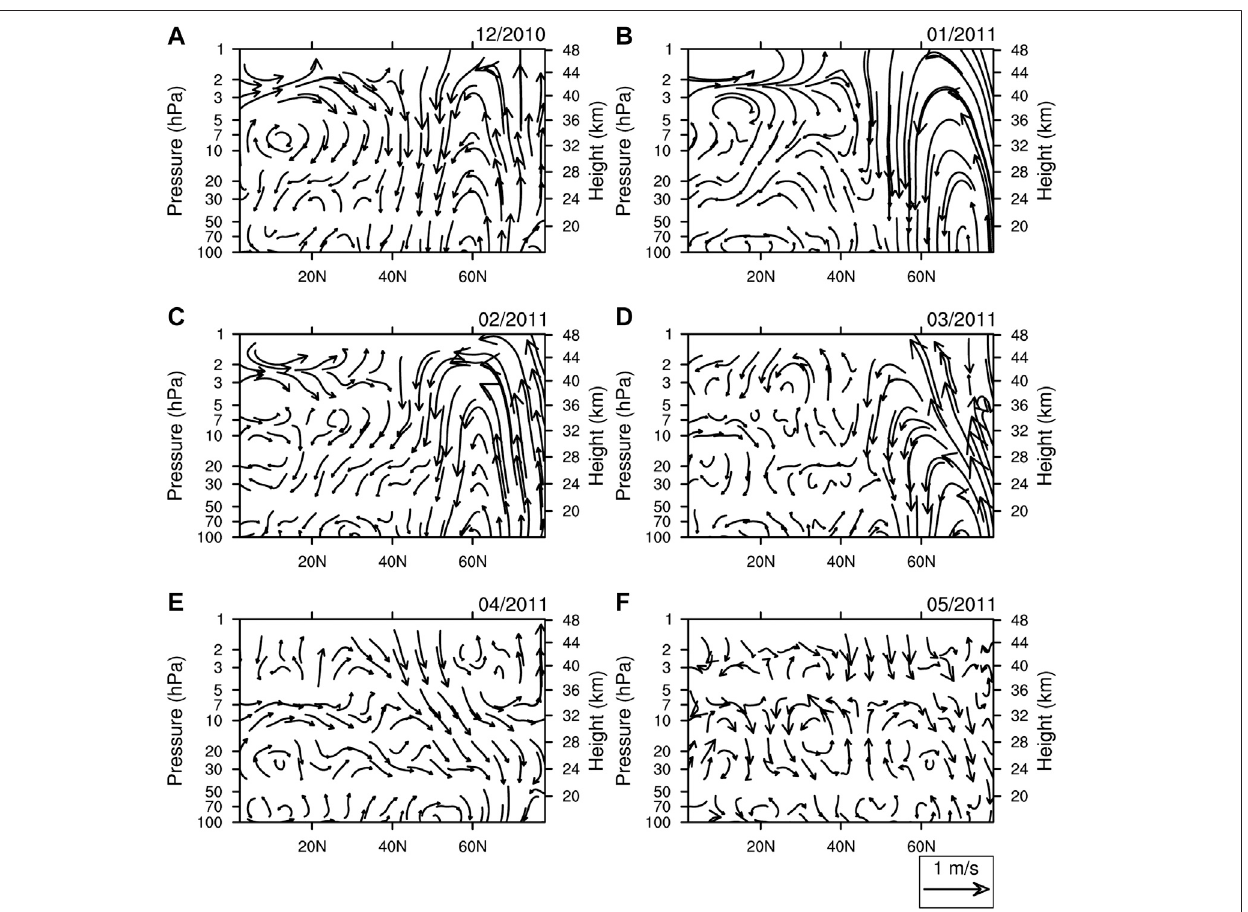
FIGURE 3 | (A – F) Month-to-month evolution of the residual circulation ( v p , w p ) anomalies from December 2010 to May 2011. The anomalies are obtained by removing the seasonal cycle. The vertical component of the residual circulation ( w p ) has been multiplied by 500. ERA-Interim data are used to calculate the residual circulation, following Seviour et al. (2012) and Abalos et al.